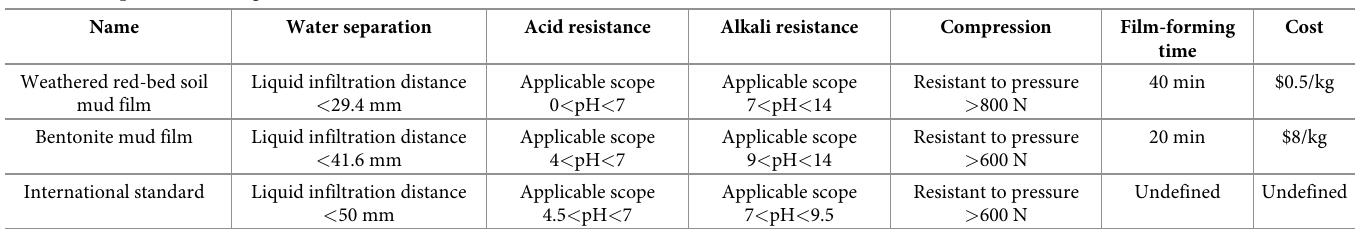
Table 7. Comparison of ecological restoration standards.